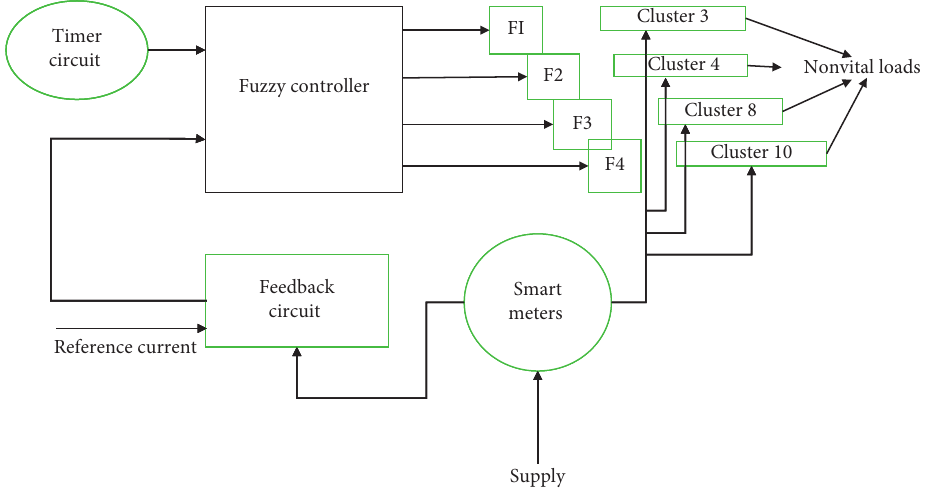
Figure 4: Proposed model for fuzzy logic load